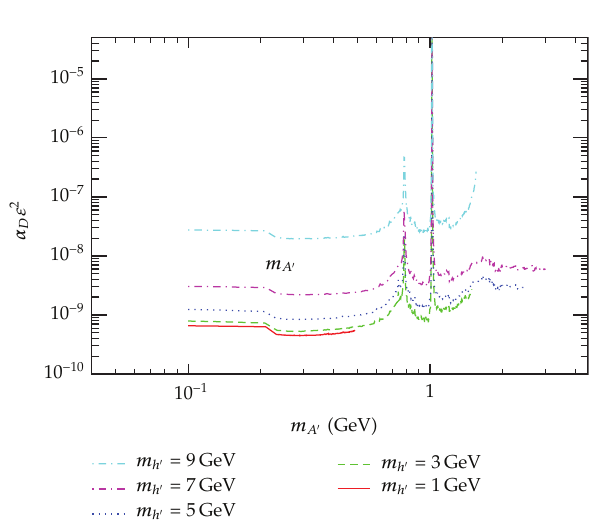
Figure 5: The 90% confidence level upper limit derived by BABAR on the product α D (cid:8) 2 as a function of the hidden photon mass (cid:2) m A (cid:6) (cid:3) for selected values of hidden Higgs boson masses (cid:2) m h (cid:6) (cid:3)